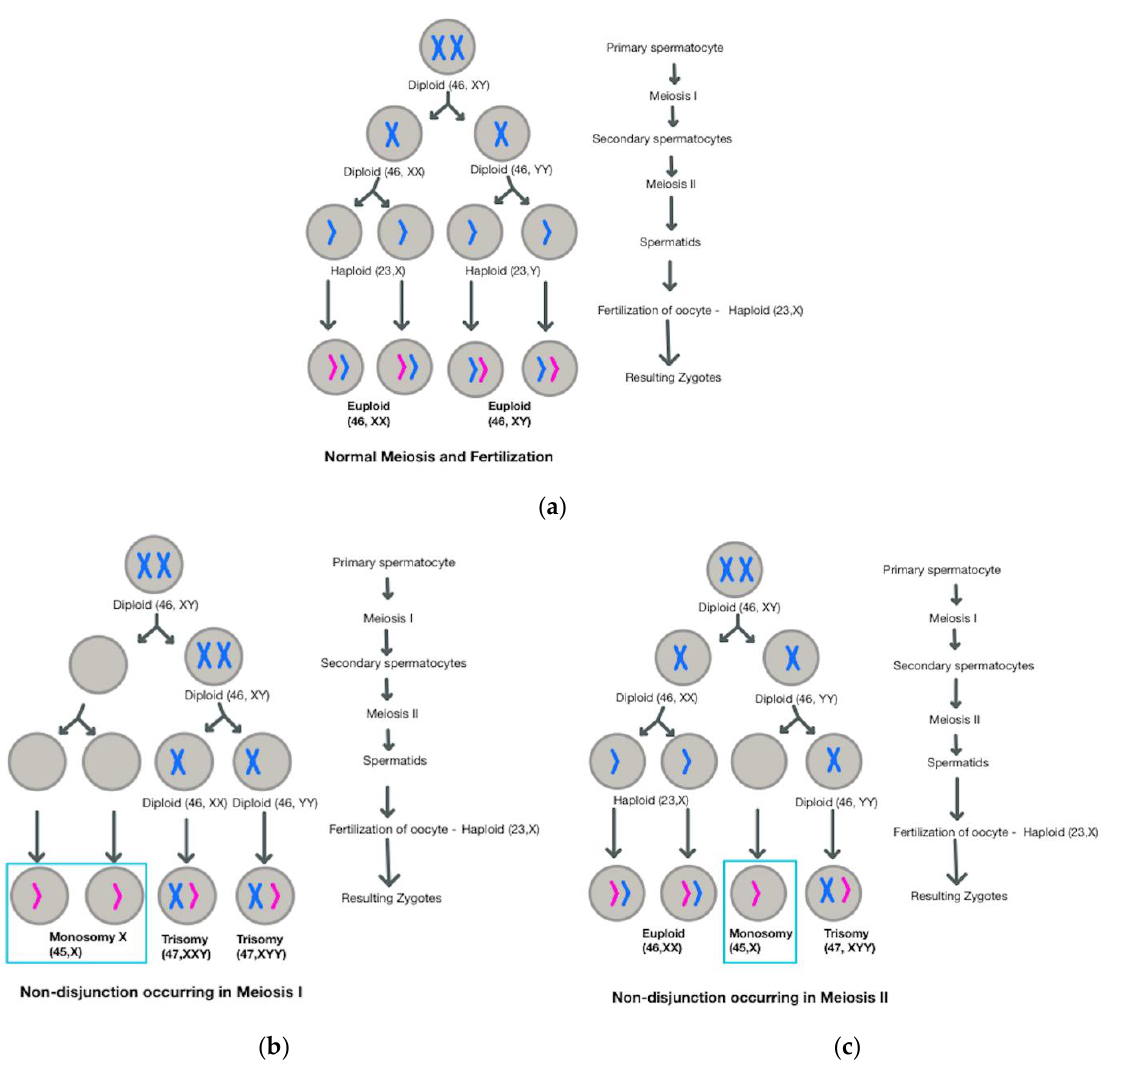
Figure 1. Comparison of ( a ) normal meiosis with ( b ) non-disjunction occurring in Meiosis I and ( c ) non-disjunction occurring in Meiosis II.